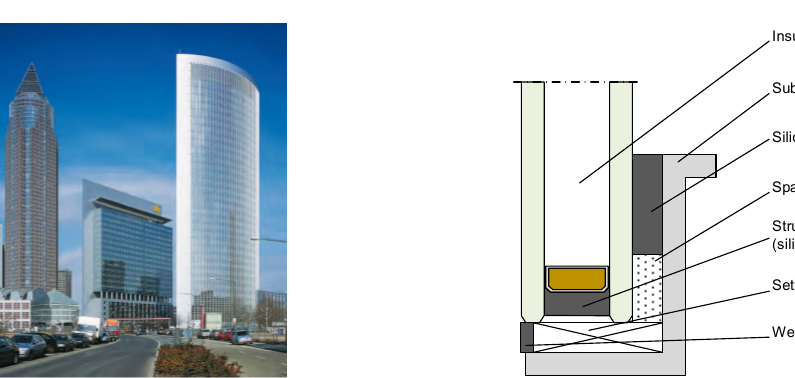
Fig. 1 Two sided structural sealant glazing system, Pollux and Castor towers in Frankfurt/Main, Germany (Dow Corning 2010)